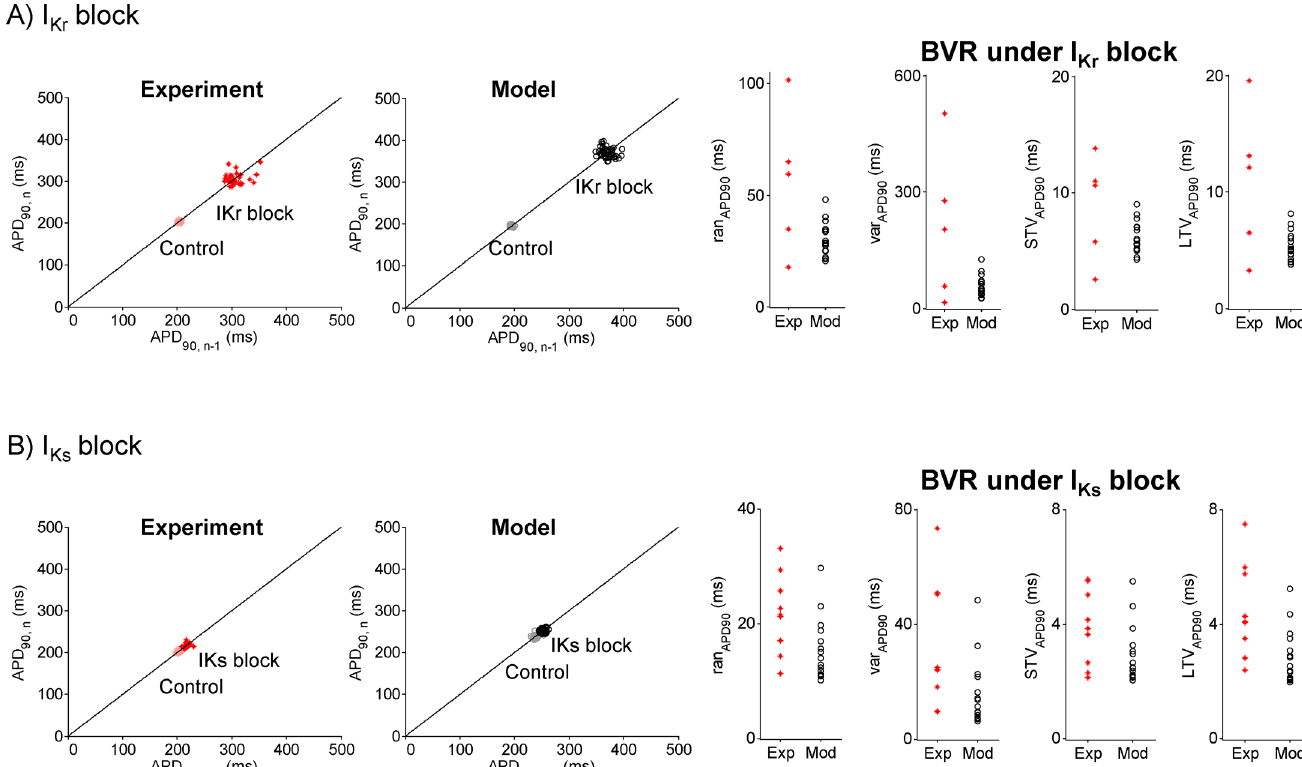
Fig 5. Results from population of stochastic models under I Kr and I Ks inhibition. A) Left: Poincaré plots for an individual experiment and a model realization under control and following I Kr inhibition. Right: BVR measures in experiments (red crosses) and simulations (black open circles), calculated in mean over realizations, under I Kr inhibition. The BVR measures, from left to right, are as follows: ran APD , var APD , STV APD and LTV APD . B) As in A) but following I Ks